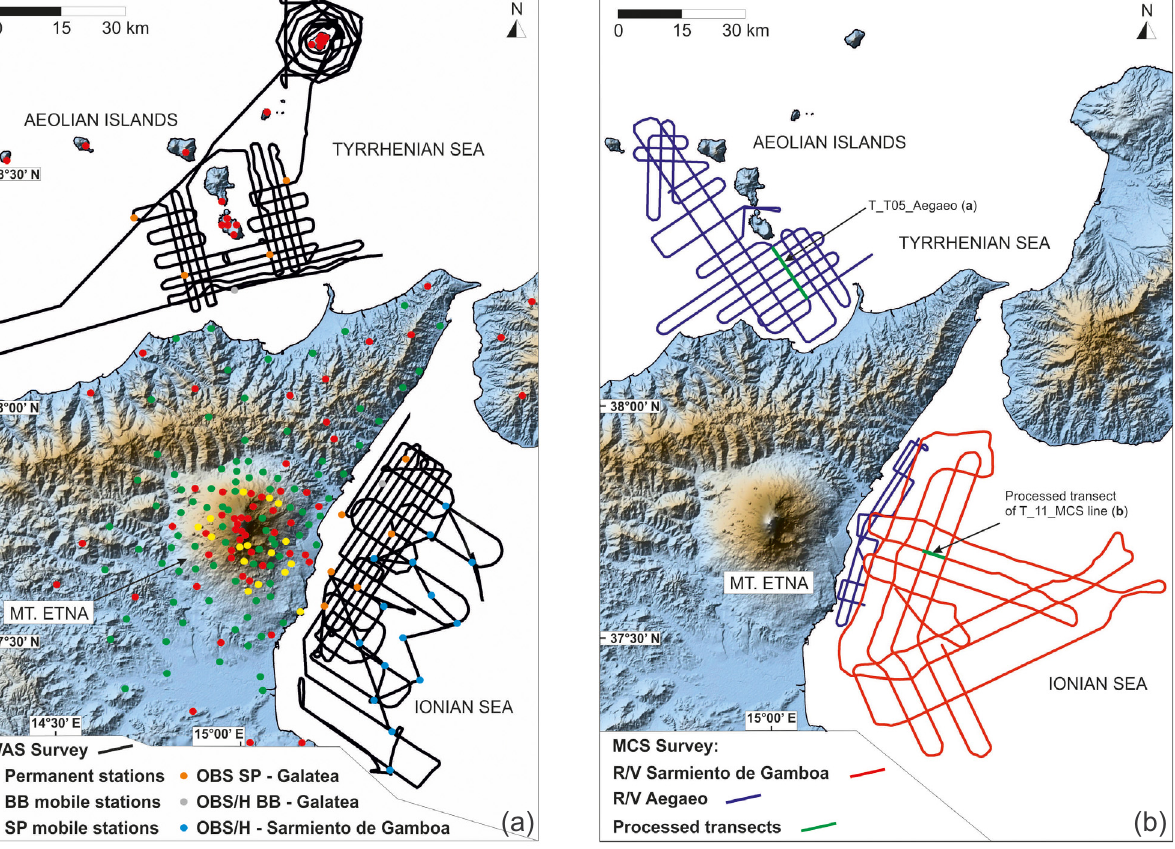
Figure 2. Lines of shots: (a) wide angle seismic (WAS) for the “Sarmiento de Gamboa” campaign. Colored dots indicate the position of the seismic stations (see legend in the figure for details); (b) multi-channel seismic (MCS) lines for the “Sarmiento de Gamboa” and “Aegaeo” cam- paign. (Figure 2 continues on next